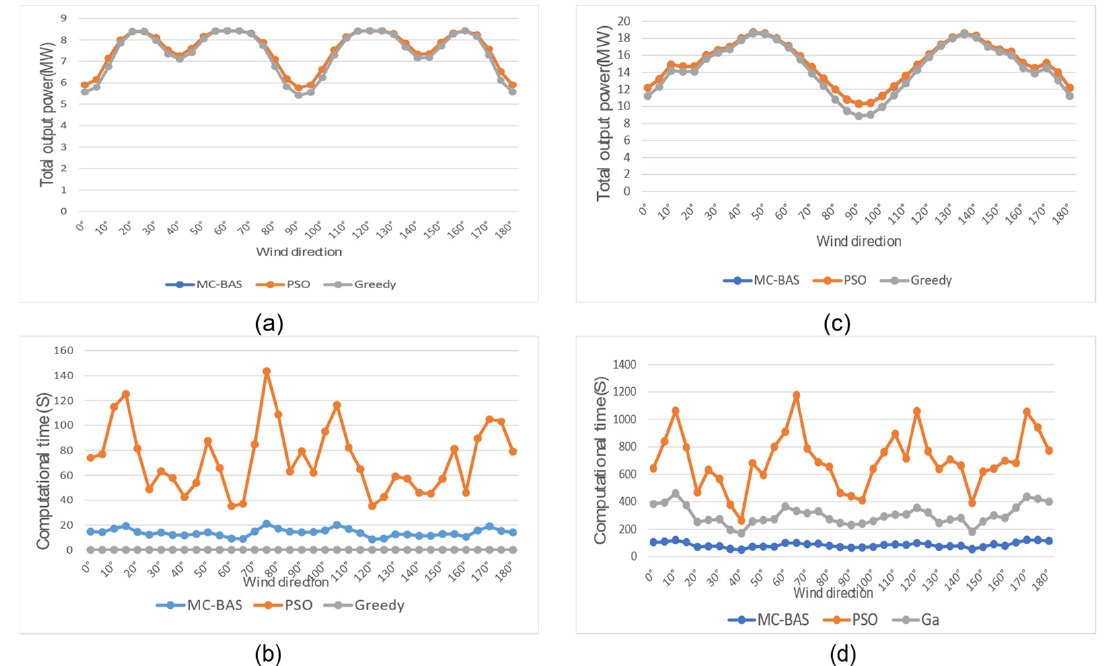
Figure 11. Comparison of the centralized MC-BAS algorithms with other iteration methods: ( a ) the total power conversion with 2 × 2 matrix turbines; ( b ) the calculating time with 2 × 2 matrix turbines; ( c ) the total power conversion with 3 × 3 matrix turbines; ( d ) the calculating time with 3 × 3 matrix turbines.